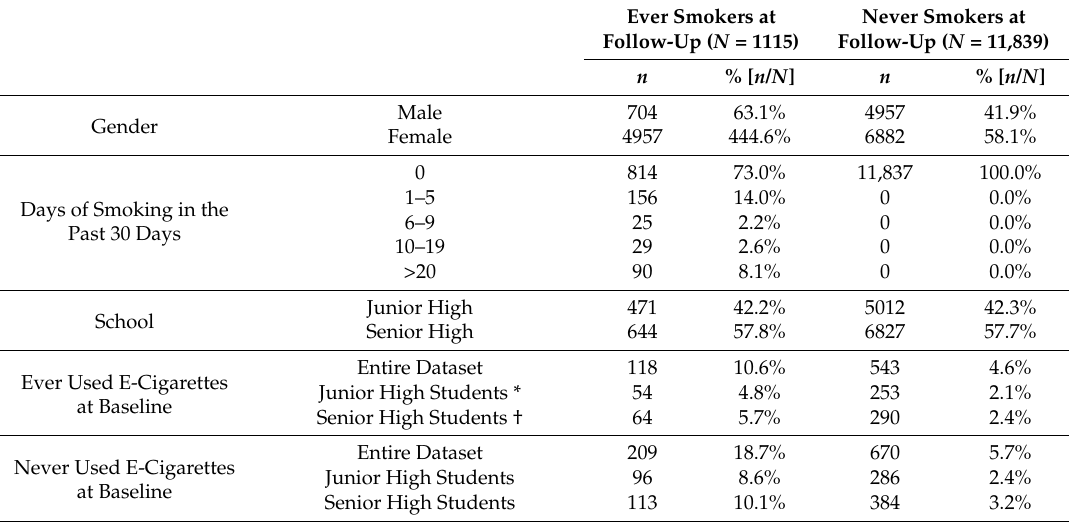
Table 1. Sample characteristics by ever smoking status at follow-up, among never smokers at baseline—unweighted